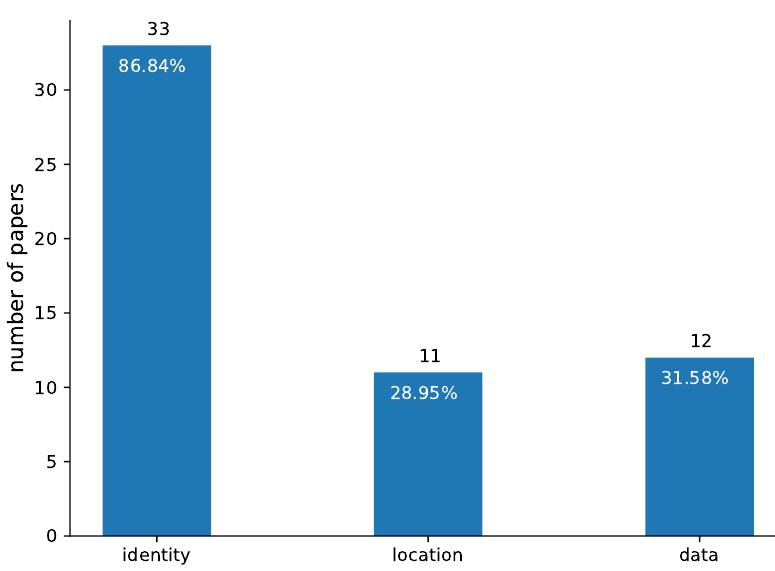
Figure 4. Service areas (RQ1) addressed in the papers included in our review.